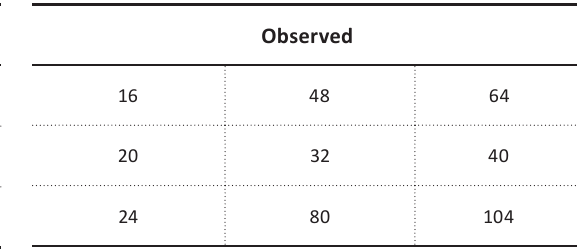
Table 8. Observed frequencies for H2 Source: Own survey.